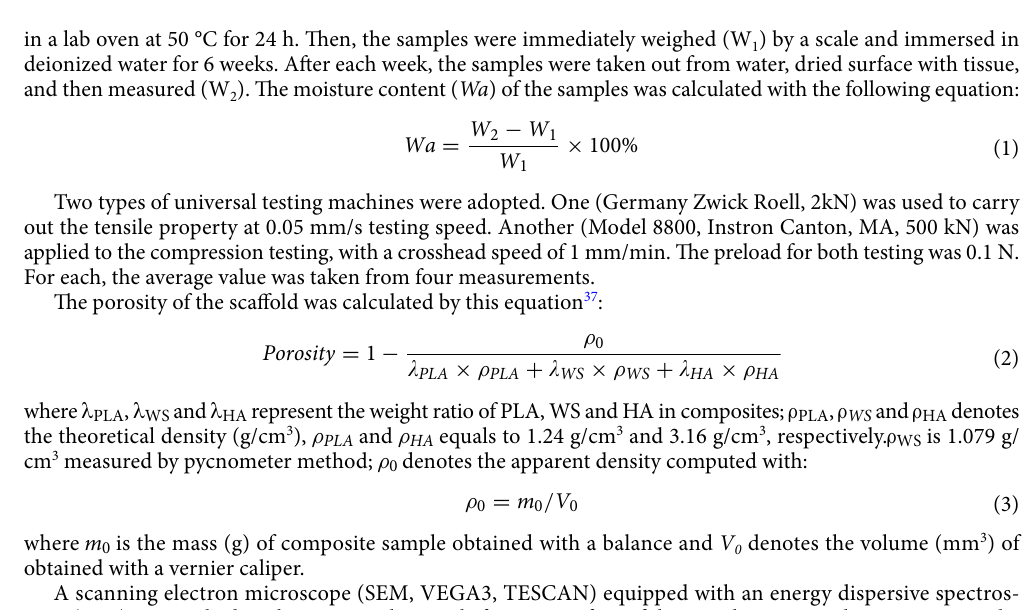
Figure 2. Morphology of HA: ( a ) untreated, ( b ) magnified image of the red rectangle in ( a , c ), treated and d, magnified image of the red rectangle in ( c